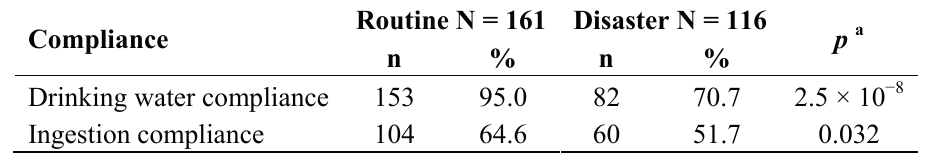
Table 7. Comparison of compliance between routine incident and natural disaster respondents.